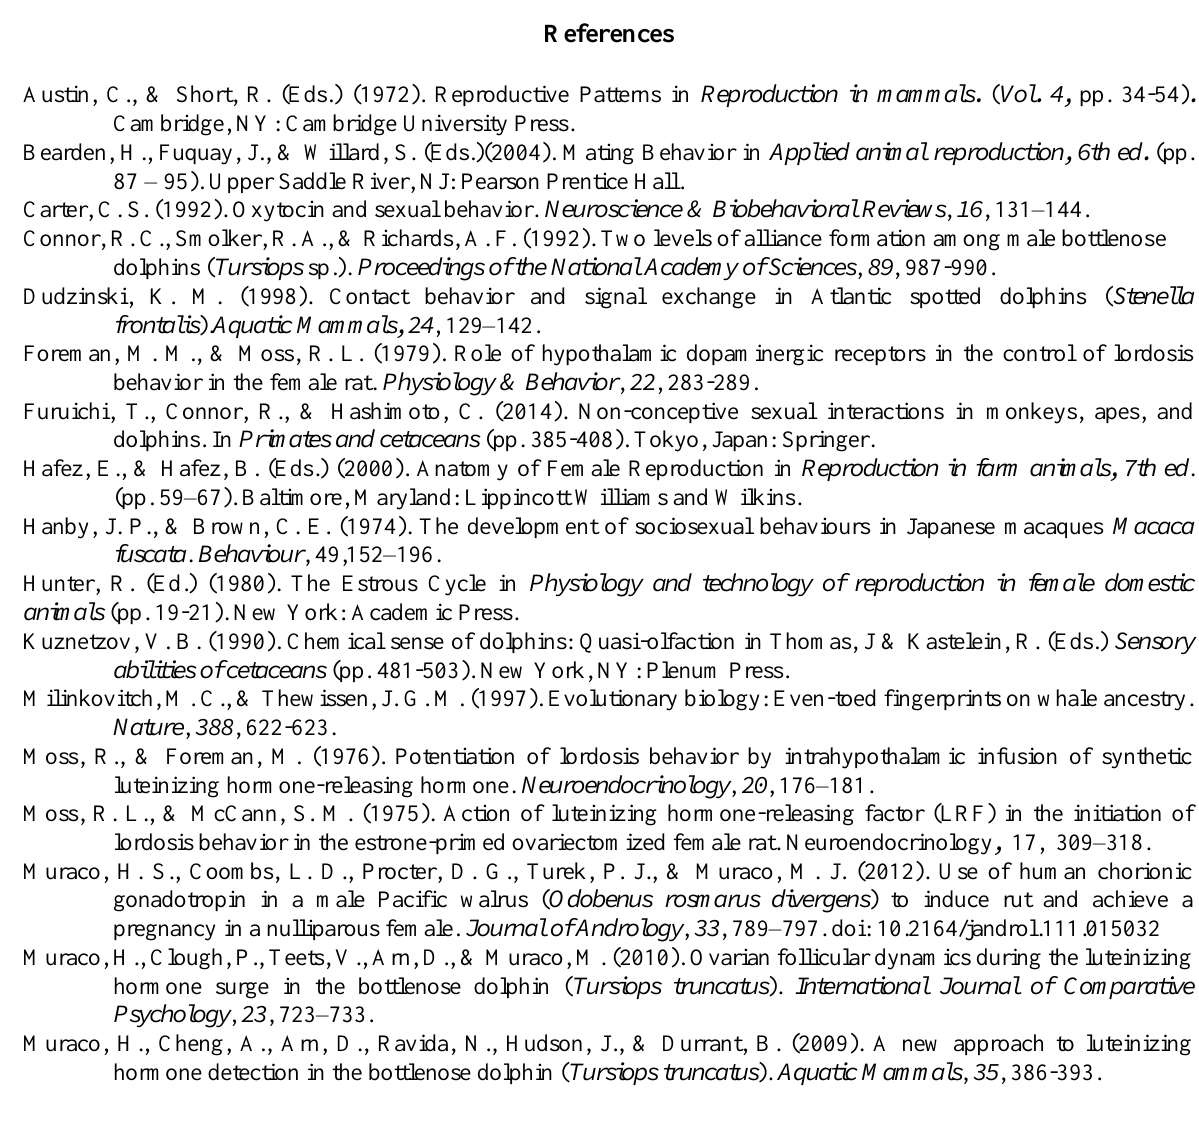
Figure 16. Mount (MNT) by animal 8 to animal